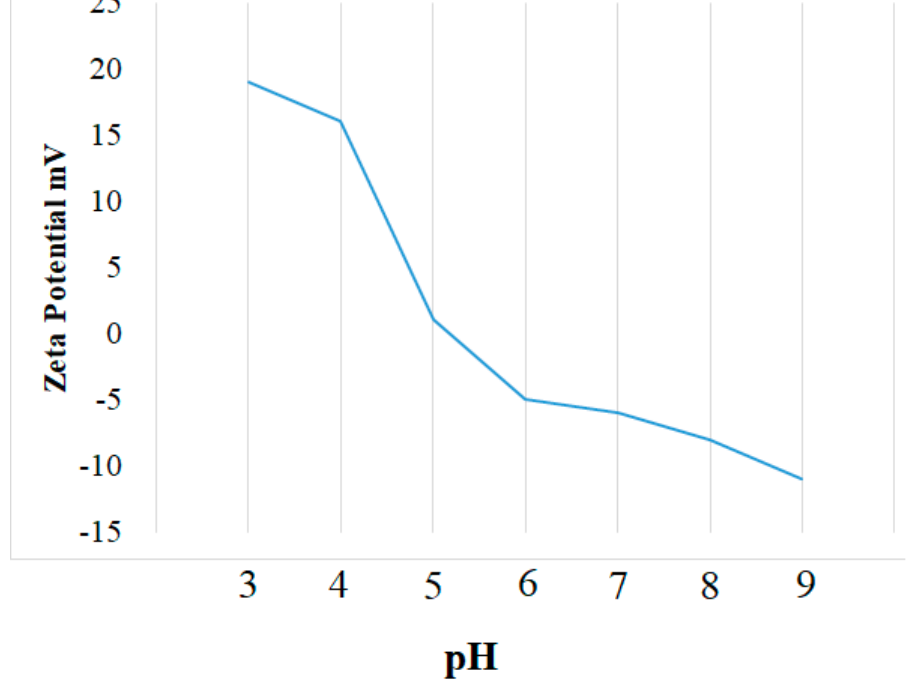
Figure 5. The zeta potential of CMCAB in pH (3–9).